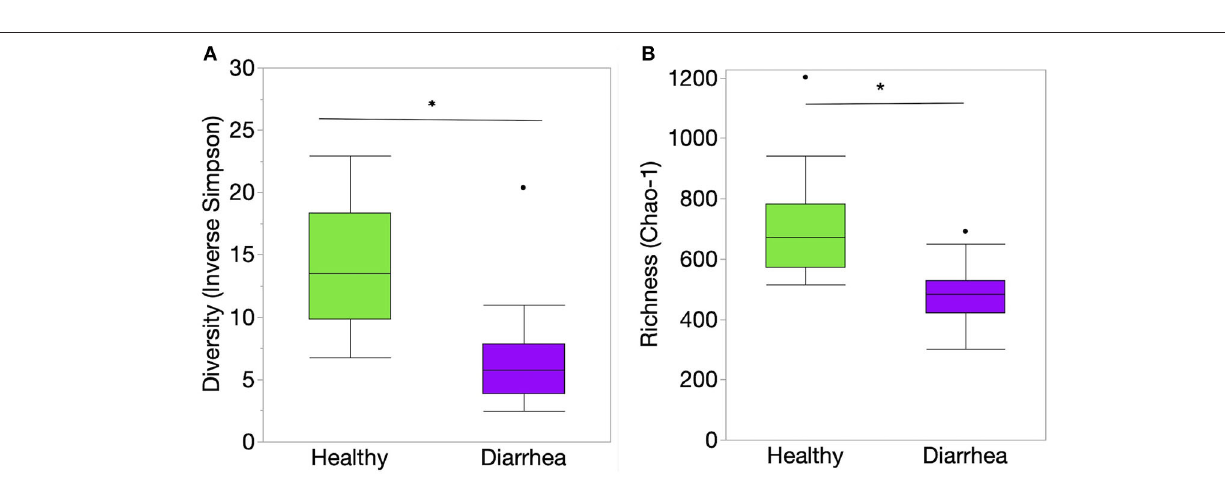
FIGURE 2 | Indices of alpha diversity at the genus level of taxonomy of the fecal samples from healthy and diarrheic calves represented by box and whisker plots. (A) Diversity (Inverse Simpson’s diversity index); (B) Richness (Chao-1 index). Level of significance * P < 0.001. The center line denotes the median value (50th percentile), while the upper and lower bounds of each box represent the 25th and 75th percentiles, respectively. The whiskers mark the 95th and 5th percentiles. Outliers are denoted with dots ( · ). The P values were obtained using the non-parametric Steel-Dwass test for multiple